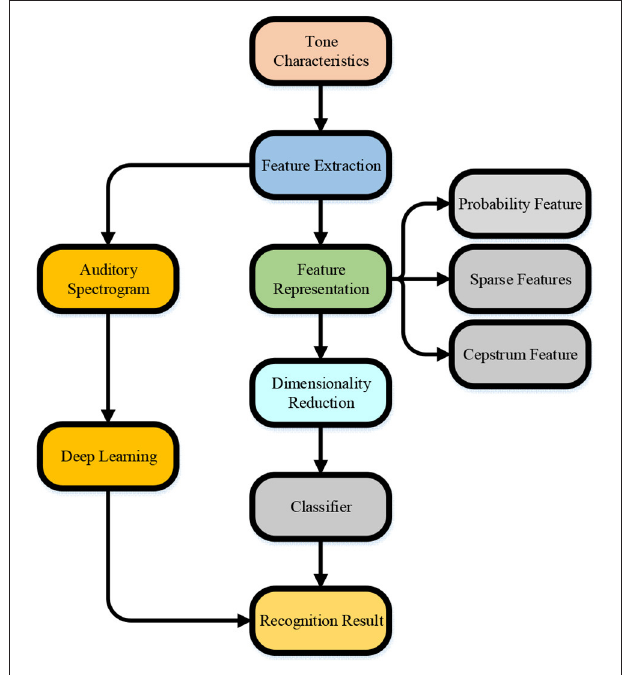
FIGURE 1 | Technological process of musical instrument